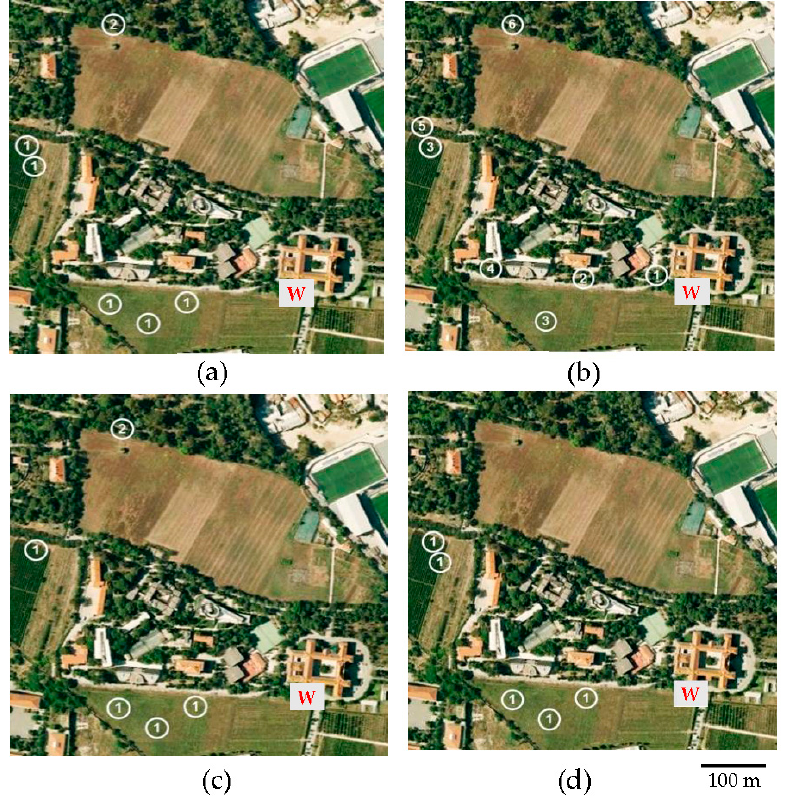
Figure 1. Sites of sampling in the environment at different distance from the winery building (W):